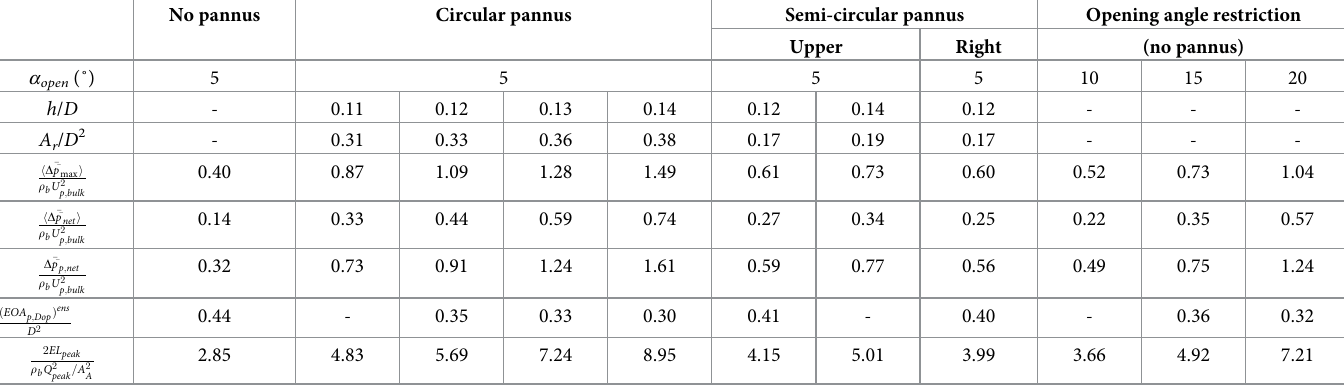
Table 1. Mean systolic plane-averaged maximum and net pressure drops, peak plane-averaged net pressure drop, ensemble-averaged peak effective orifice area, and peak energy loss coefficient. Here, the net pressure drop is the pressure difference between at x / D = 0 and 4, and A r is the flow area reduced by pannus. No pannus Circular pannus Semi-circular pannus Opening angle restriction Upper Right (no